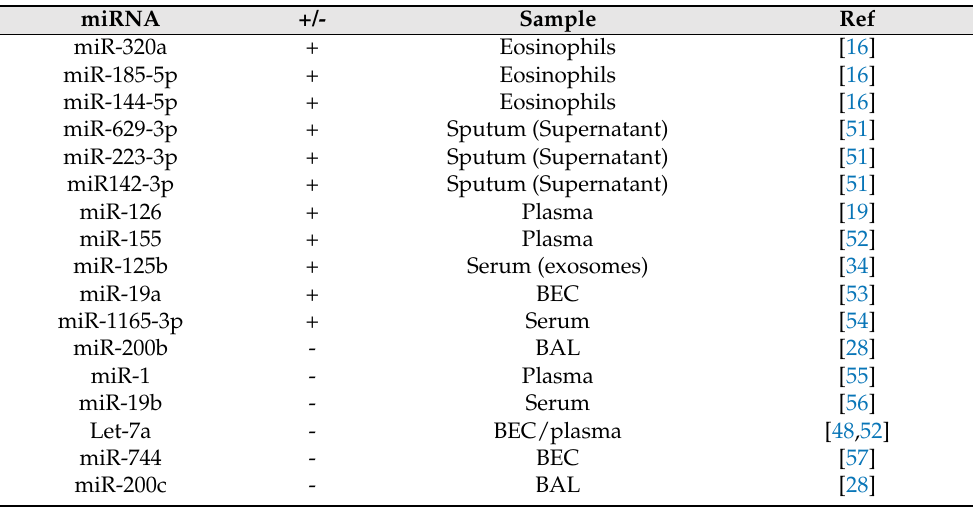
BAL: bronchoalveolar lavage. BEC: bronchial epithelial cells. +: upregulated. -: